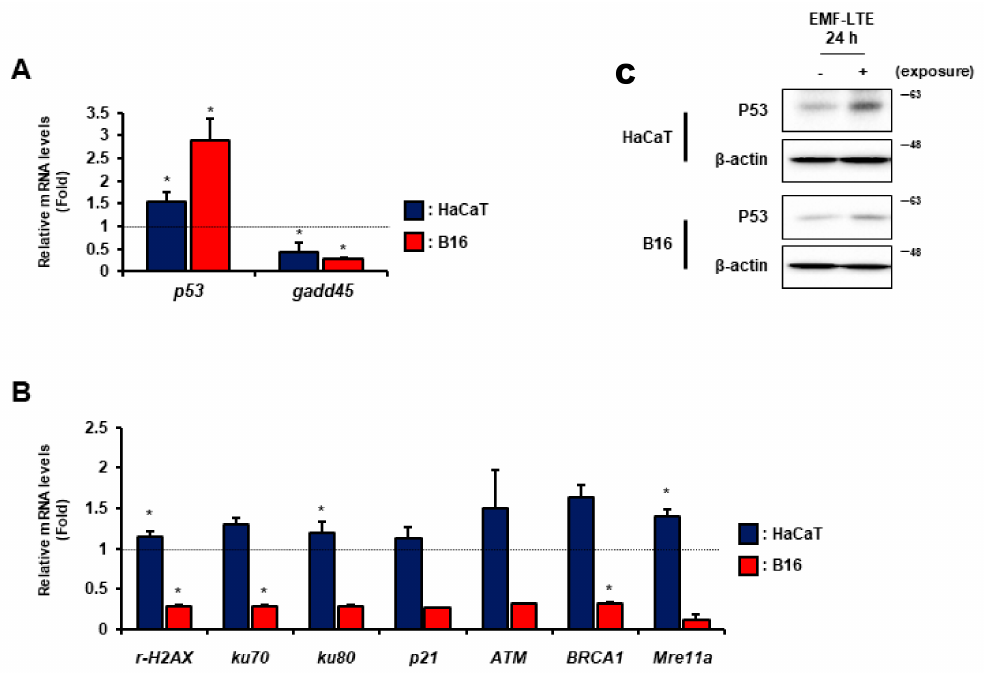
Figure 6. Effects of EMF-LTE on DNA repair genes in HaCaT and B16 cells. Real-time polymerase chain reaction (PCR) analysis to evaluate the relative mRNA levels of known DNA repair genes was performed in HaCaT ( A ) and B16 cells ( B ). Each mRNA expression was normalized to that of GAPDH (glyceraldehyde 3-phosphate dehydrogenase), which is an internal control gene. The data reflect the mean ± SD. Statistical significance was measured using the t -test. Fold change values were generated after normalization with average values of the unexposed control. ( C ) Western blot analysis for P53 was performed with β -actin as a loading control. Representative photos are presented. * p <